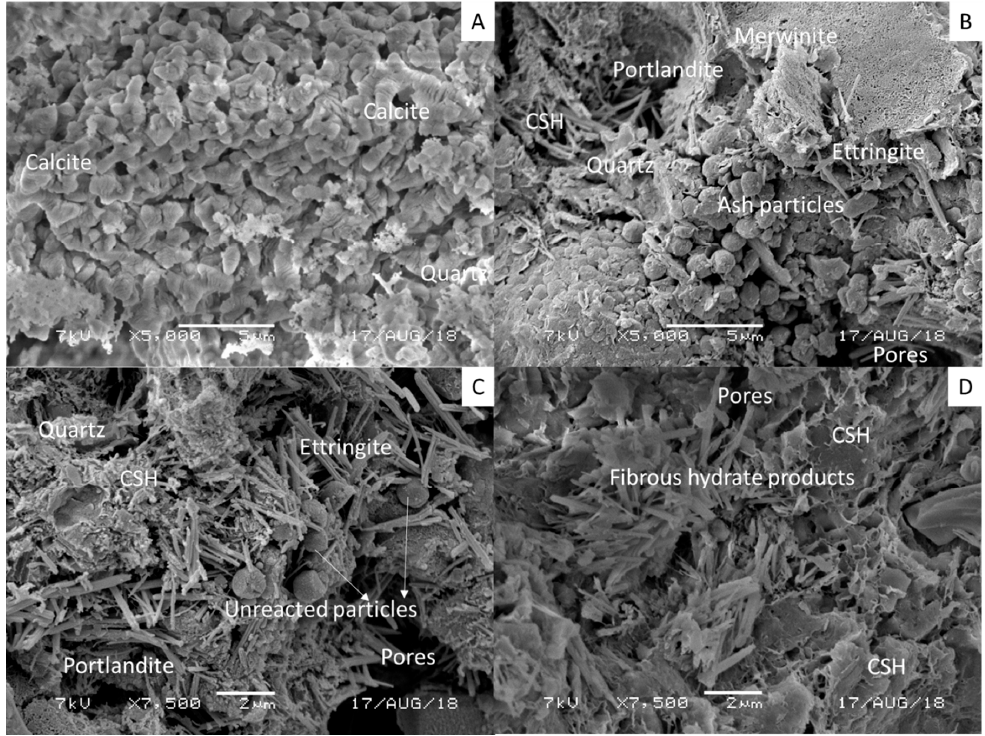
Figure 14. The scanning electron microscopy images, conducted on ( A ) wood-ash at ( B ) 7 days, ( C